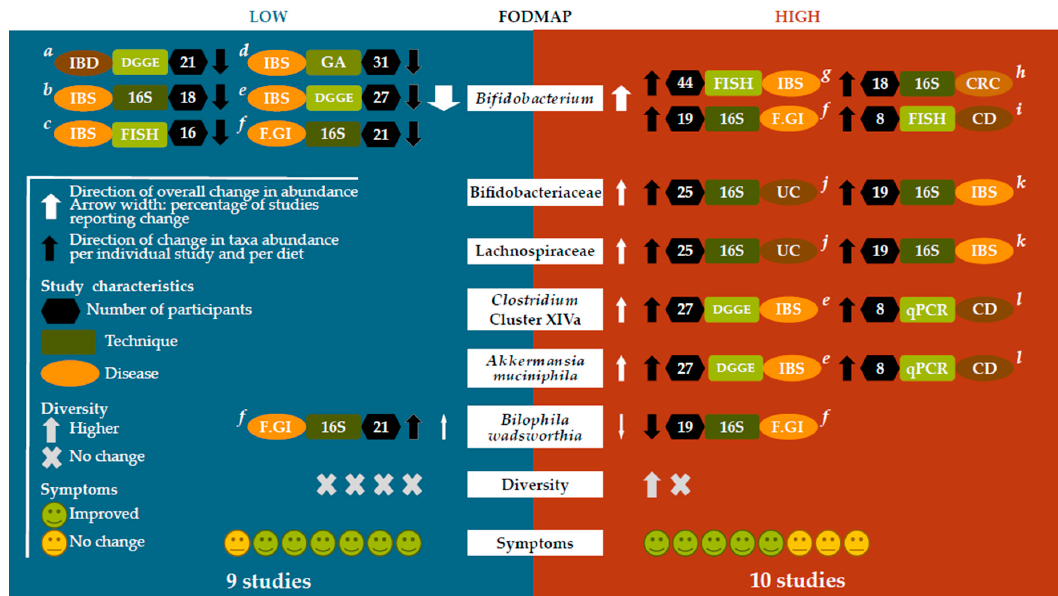
Figure 2. Graphical summary of the main findings. Overview of significant findings with low FODMAP diets (left, 9 studies) versus high fermentable carbohydrate intake (right, 10 studies) for taxonomic groups reported at two instances ( Bifidobacterium , Bifidobacteriaceae, Lachnospiraceae, Clostridium cluster XIVa, Akkermansia muciniphila and Bilophila wadsworthia ), as well as diversity measures (Diversity) and symptom severity (Symptoms). Studies not included in the figure did not report any significant change regarding the respective parameter. All individual study results are referenced (white